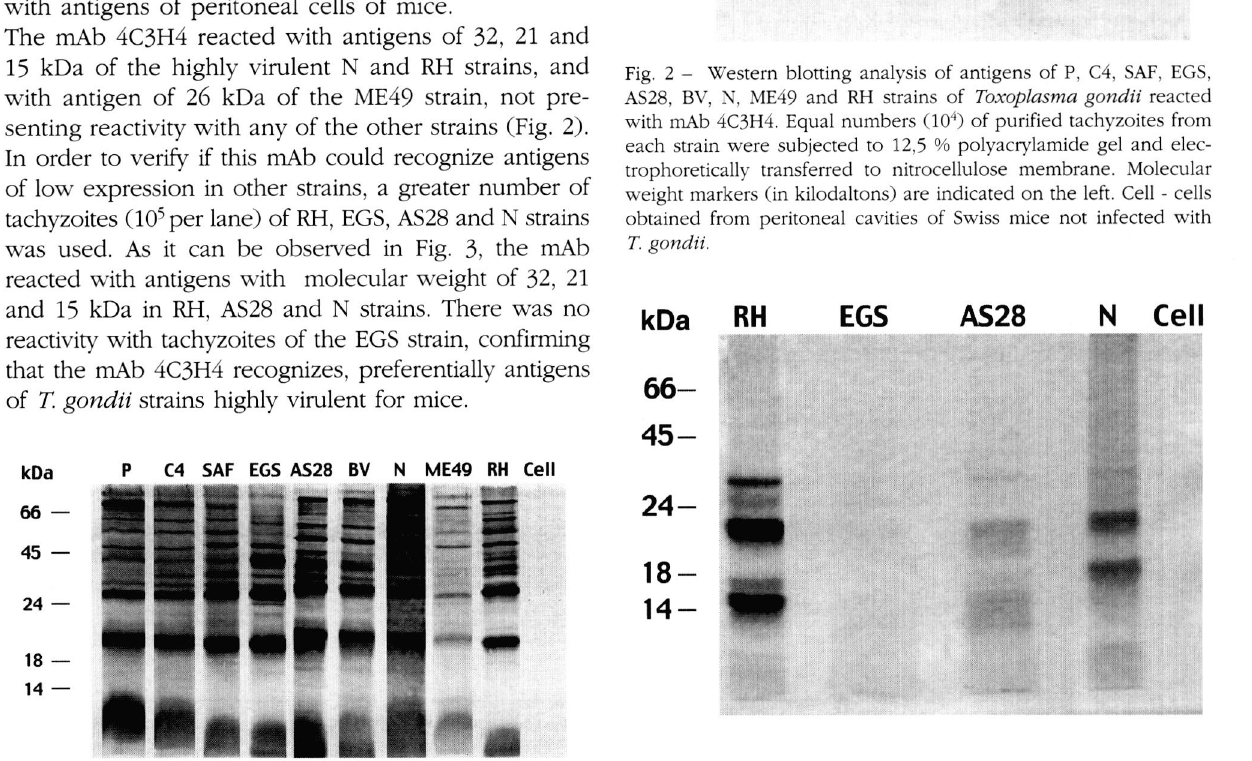
Fig. 3 - Western blotting analysis of antigens of RH. EGS, AS28 and N strains of Toxoplasma gondii reacted with mAb 4C3H4. Equal num­ bers (10 5 ) of purified tachyzoites from each strain were subjected to 12,5 % polyacrylamide gel and electrophoretically transferred to nitrocellulose membrane. Molecular weight markers (in kilodaltons) are indicated on the left. Cell - cells obtained from peritoneal cavi­ ties of Swiss mice not infected with T.